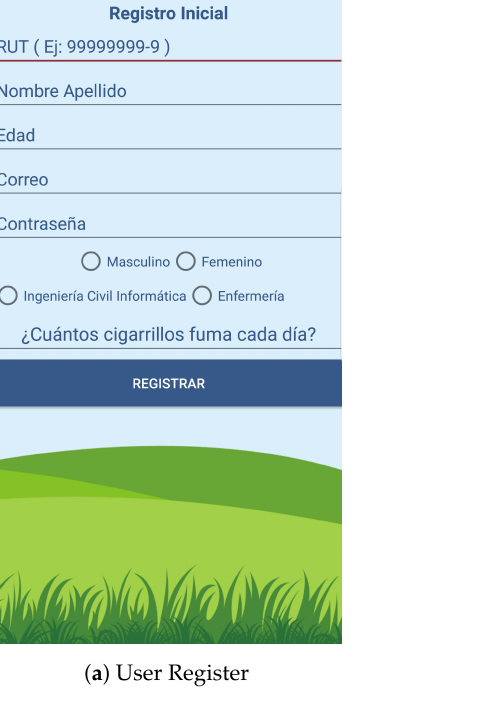
Figure 2. Evitapp Final Version: Smoking Cessation.